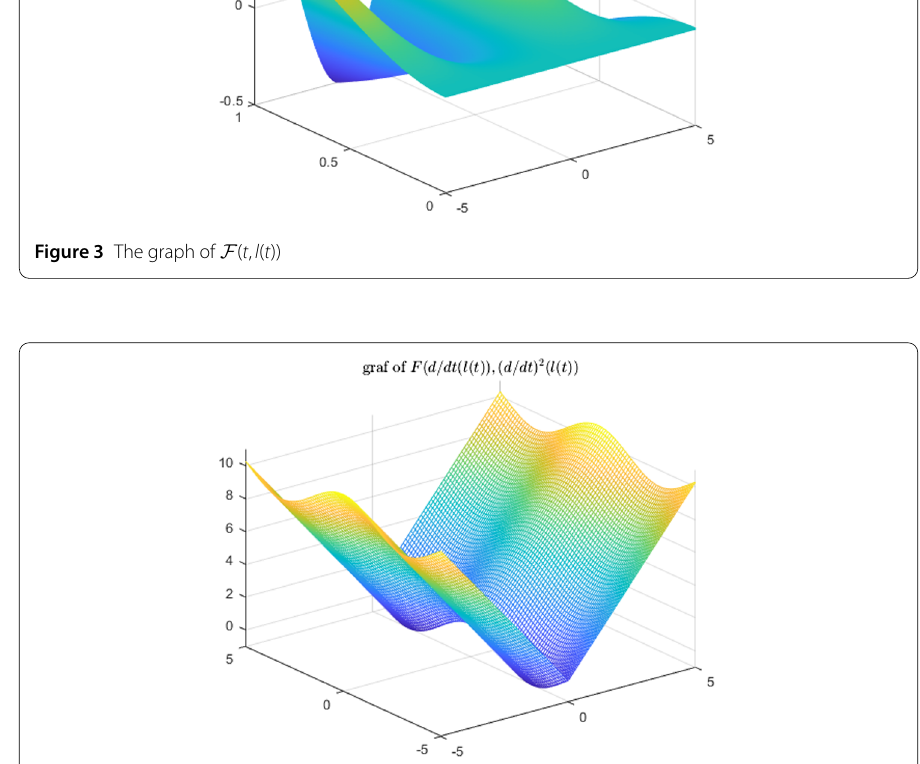
Figure 4 The graph of F ( l (cid:4) ( t ), l (cid:4)(cid:4) ( t